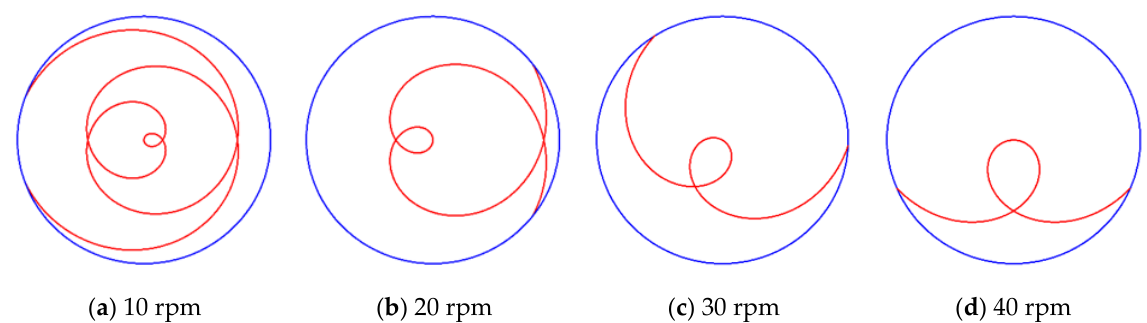
Figure 20. Motion trajectory of agglomerated particles with different polishing disc speeds.